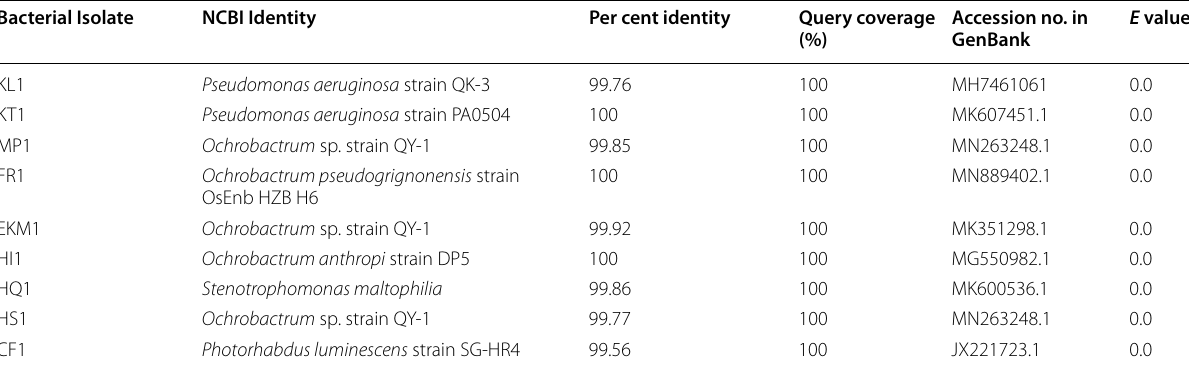
Table 3 Homology of 16S rRNA gene sequences of bacteria in NCBI database Bacterial